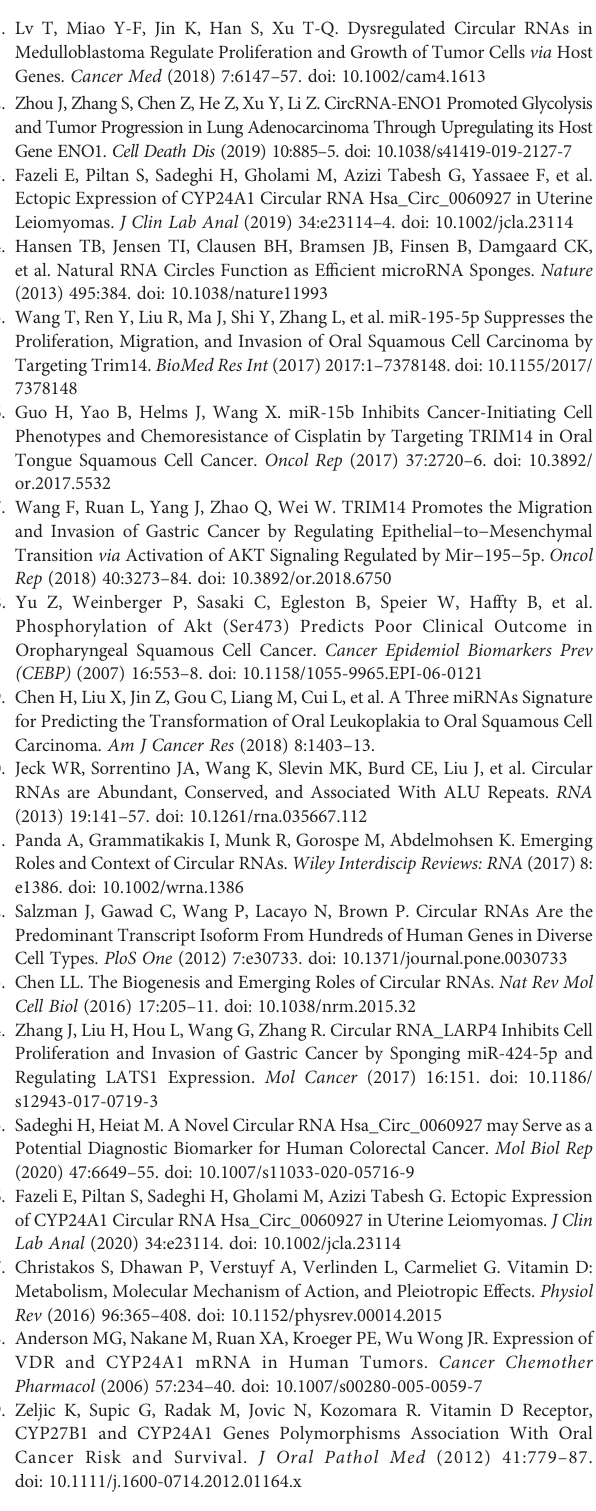
Supplementary Figure S1 | The clinical lesion manifestation of OLK and malignant transformation of OLK. (A) The clinical feature of OLK, OLK can occurs in any part of the oral mucosa, including tongue, buccal, palate and gingiva etc. (B) The clinical manifestation of malignant transformation of OLK.